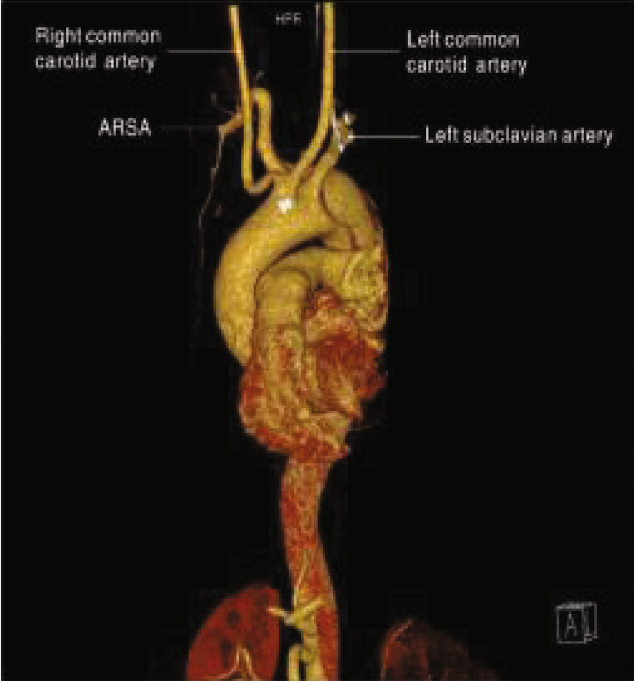
Figure 3: Adapted from “ Repair of a type B aortic dissection with a re-vascularization of the aberrant right subclavian artery in an adult patient.